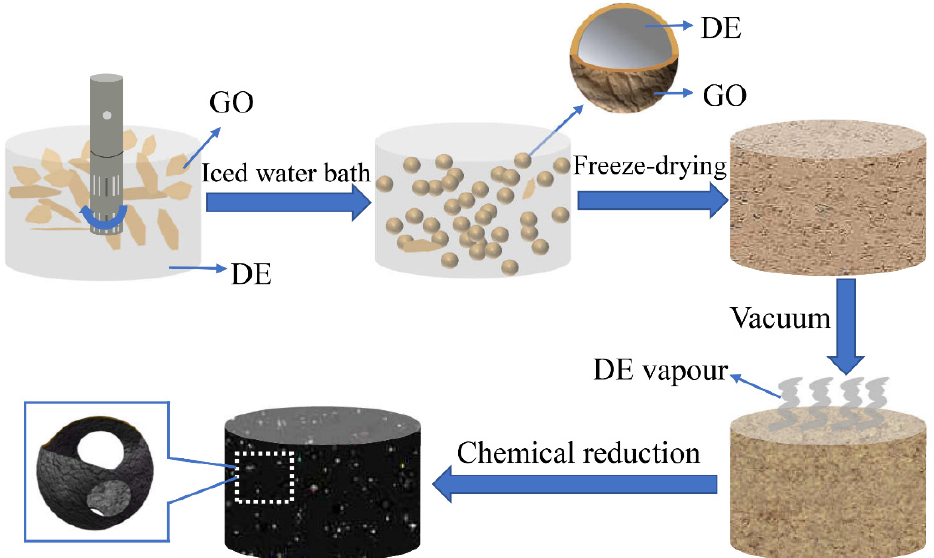
Figure 2. Schematic illustrations of the fabrication of the OCGA.